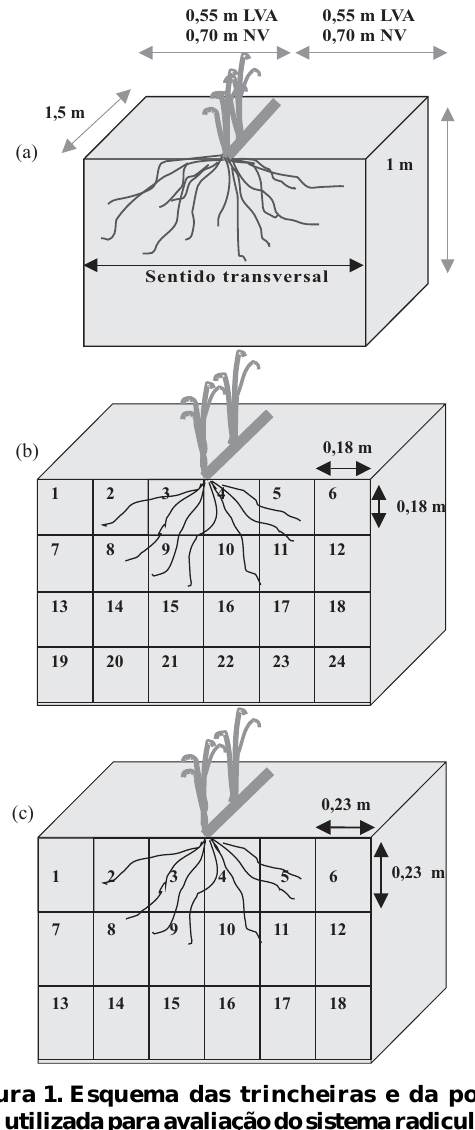
Figura 1. Esquema das trincheiras e da posição utilizada para avaliação do sistema radicular (a); número e dimensões das quadrículas em perfil no LVA (b); número e dimensões das quadrículas em perfil no NV